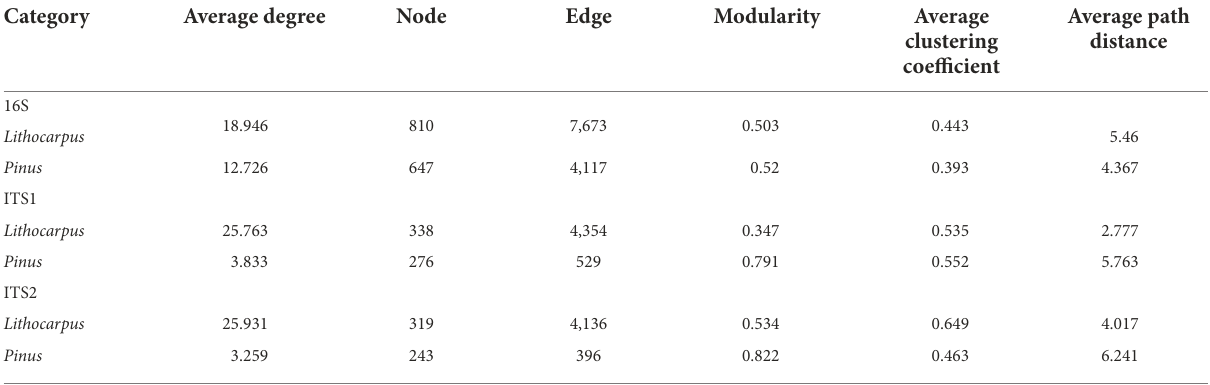
TABLE 1 Topological properties of the co-occurrence networks of Lithocarpus and Pinus ECM roots.